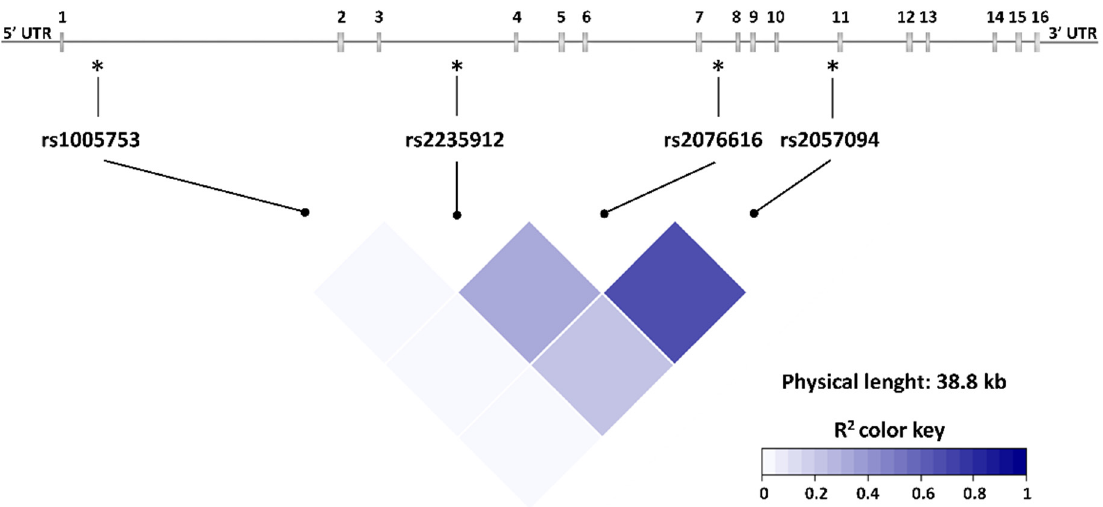
Figure 2. PADI2 SNPs location in the gene and linkage disequilibrium heatmap. UTR, Untranslated region, 1–16 indicates the exon number. * indicates SNP location within the PADI2 gene.